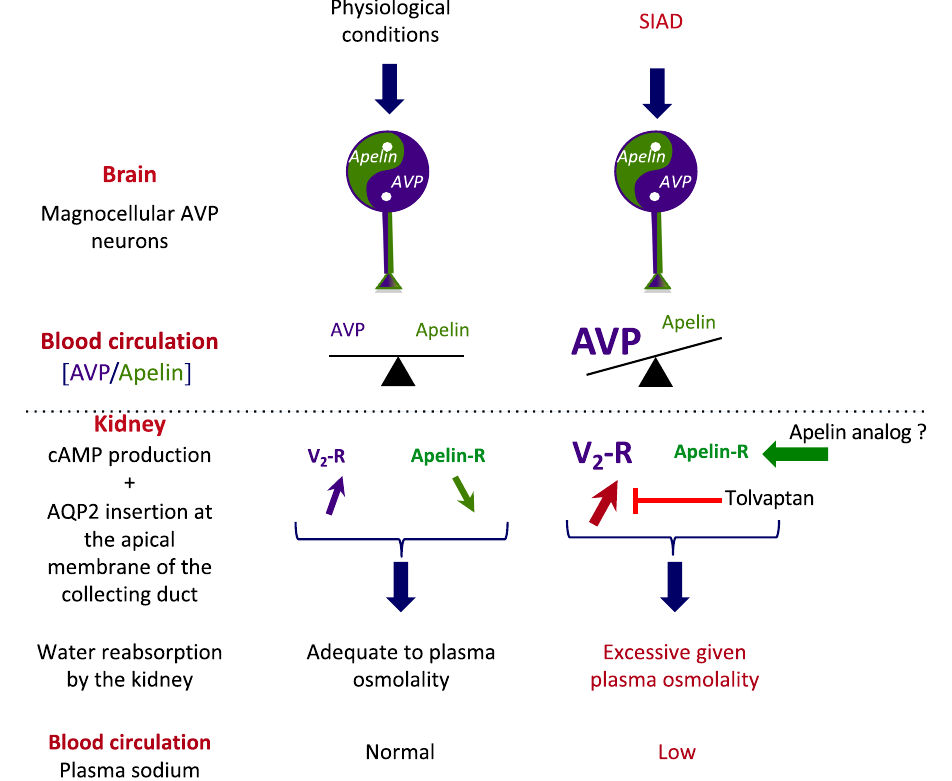
Fig. 1 Apelin and vasopressin regulation in physiological conditions and in SIAD. In physiological conditions, apelin and AVP are released in balanced proportions from the magnocellular AVP neurons at levels appropriate for plasma osmolality. In the collecting duct of the kidney, AVP acts on V2-R to increase cAMP production and aquaporin-2 (AQP-2) insertion, leading to water reabsorption. Conversely, apelin, through its action on apelin-R, has the opposite effect. In physiological conditions, water reabsorption is adequate and plasma sodium concentrations are normal. In SIAD, AVP release is excessive relative to plasma osmolality, leading to excessive water reabsorption by the kidney and hyponatremia. Tolvaptan blocks the effect of AVP on V2-R and corrects hyponatremia in SIAD. We hypothesize that the activation of apelin-R with a metabolically stable K17F analog, LIT01-196, would also correct water homeostasis in this disease. This fi gure was modi fi ed with authorization from Llorens-Cortes and Moos 54 , available at